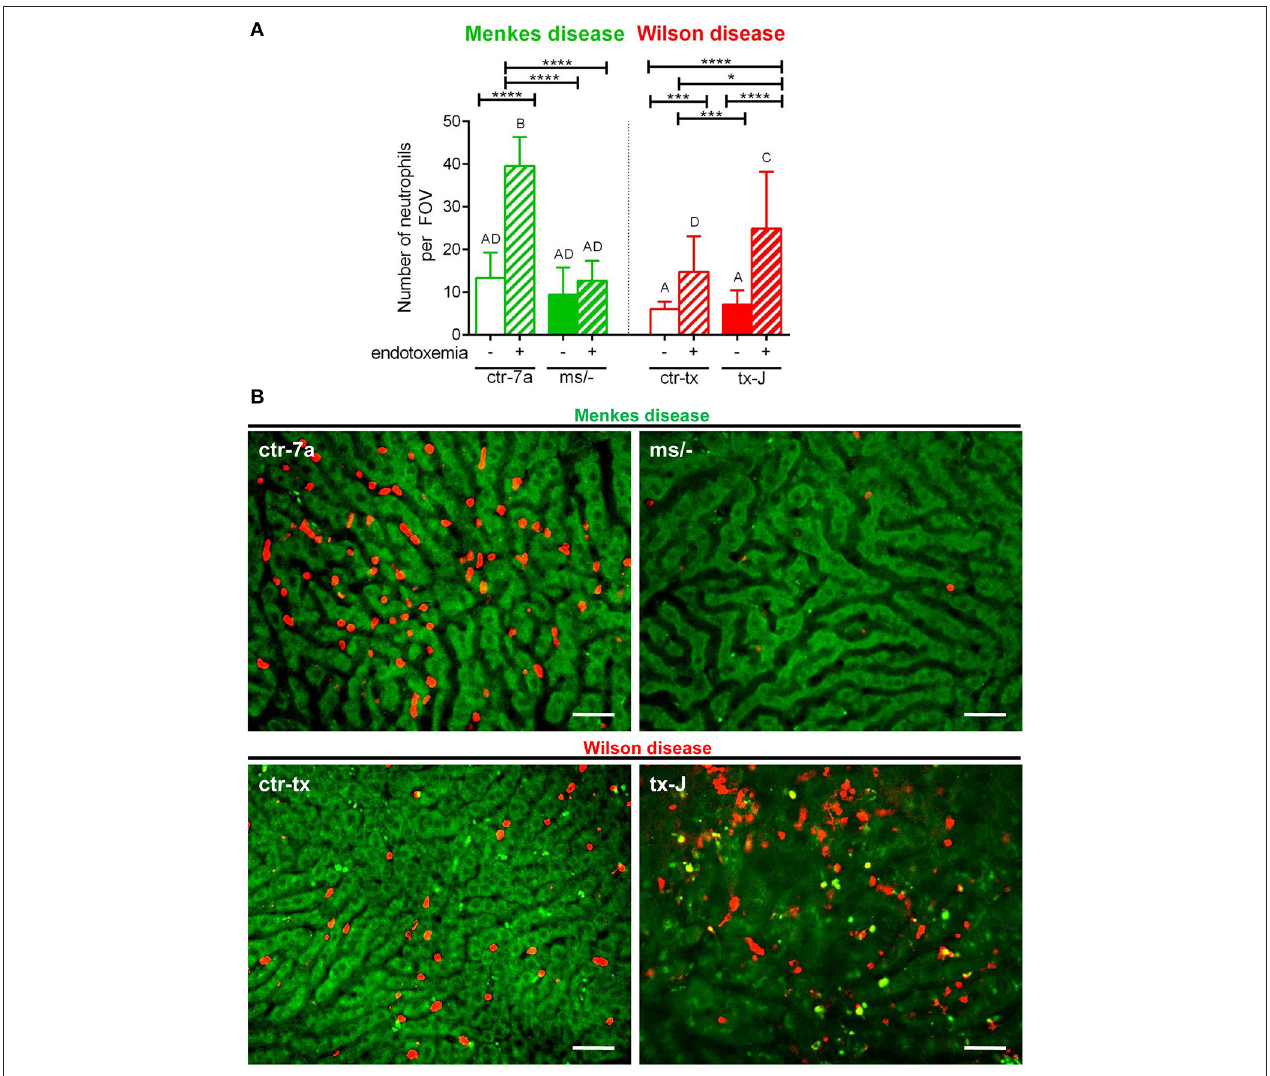
FIGURE 3 | The presence of neutrophils in livers of Wilson (tx-J) and Menkes ( ms / − ) disease mice and their respective controls (ctr-tx and ctr-7a) with systemic inflammation. Neutrophils were counted per field of view (FOV; n = 3/group) (A) . Asterisks indicate significant differences using unpaired two-tailed Student’s t test (* P ≤ 0.05, *** P ≤ 0.001, **** P ≤ 0.0001) and one-way ANOVA ( post hoc Bonferroni) test (different letters indicate statistically significant differences between groups). Representative images revealing neutrophil deposition in liver sinusoids are presented in (B) . On images, autofluorescent hepatocytes (green) can be observed, and between them, sinusoids are seen as black areas. In the latter structures, neutrophils are deposited (false red color; Brilliant Violet 421 anti-Ly6G antibody). The scale bar indicates 50 µ